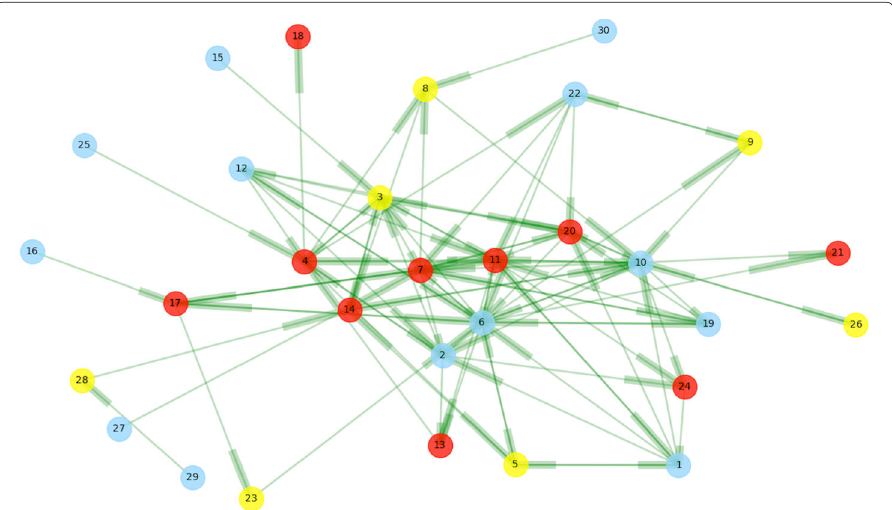
Fig. 5 Visualization of a hospital (PHN) referral network with 30 physicians and 101 directed edges in 2011. Red, yellow and lightblue nodes represent physicians with positive, zero and negative net patient flow (NPF), respectively. Targets of referrals are marked with shadow on directed edges. The edge weights are in Table